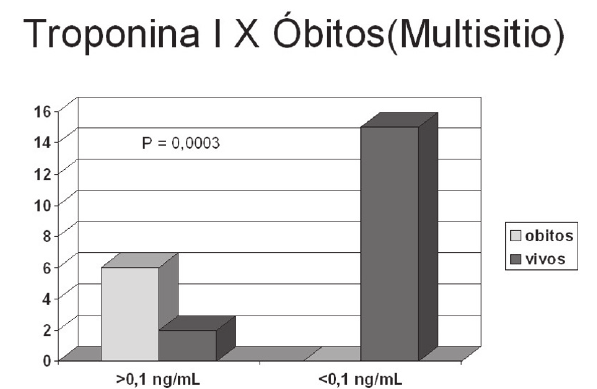
Fig. 3 - Quantificação da ocorrência de óbitos em pacientes com insuficiência cardíaca avançada submetidos a implante de ressincronizador ventricular, de acordo com os valores séricos de troponina I cardíaca na avaliação